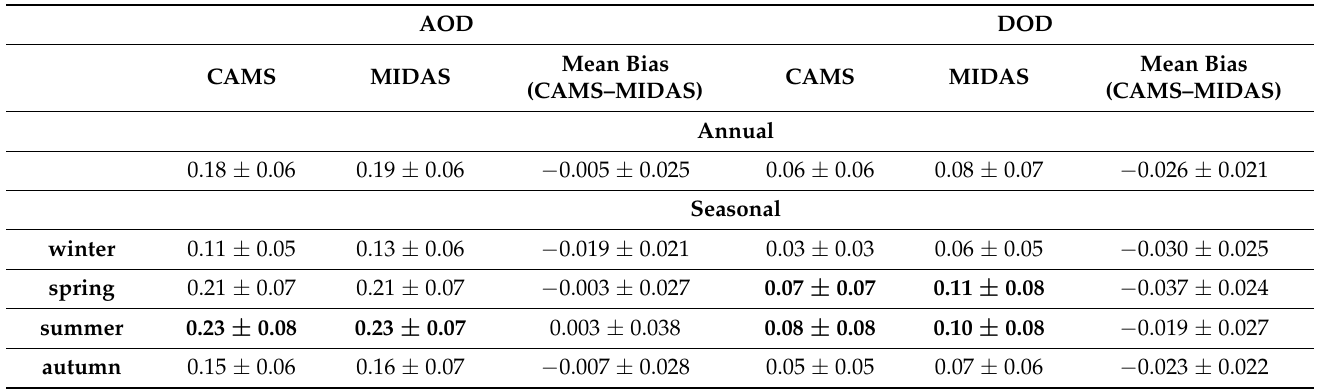
Table 3. Regional averages of mean annual and seasonal AOD and DOD at 550 nm from MIDAS and CAMS and CAMS–MIDAS bias. The maximum of seasonal values is denoted as bold, emphasizing the peak of the seasonal